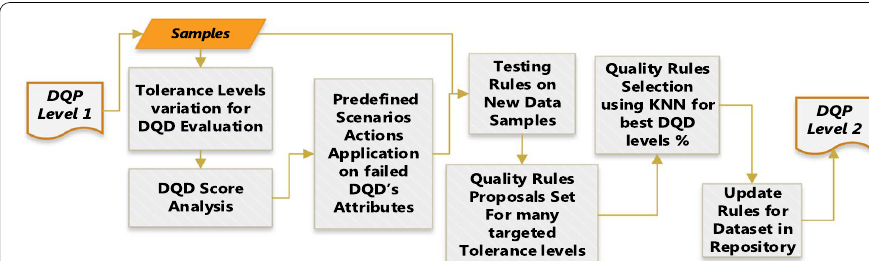
Fig. 8 Quality rules proposals with exploratory quality profiling